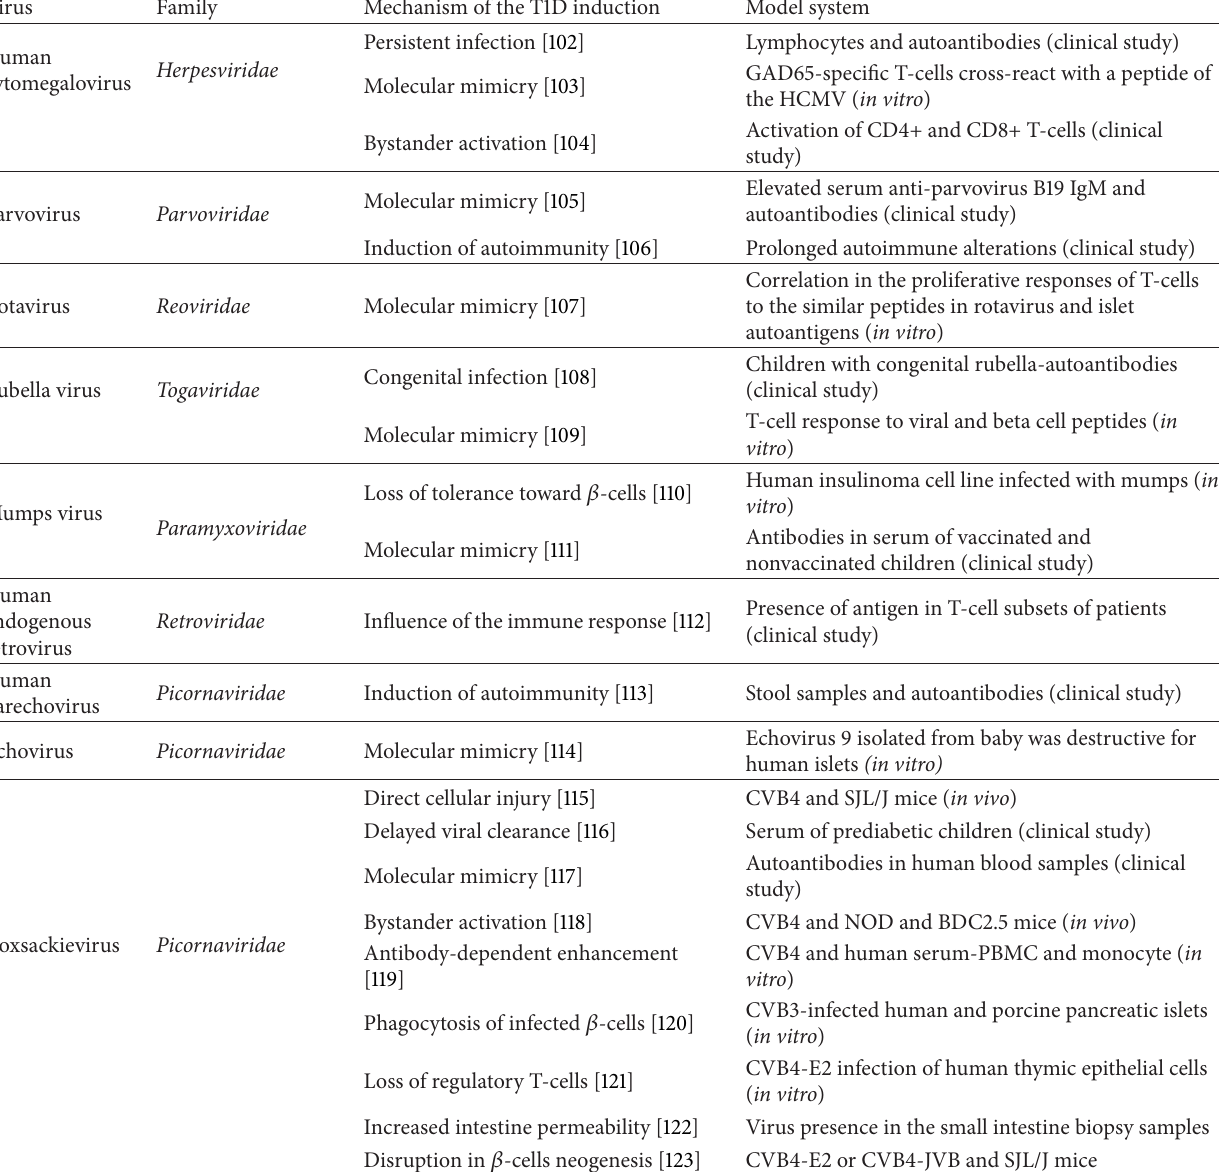
Table 5: Viruses linked with type 1 diabetes in